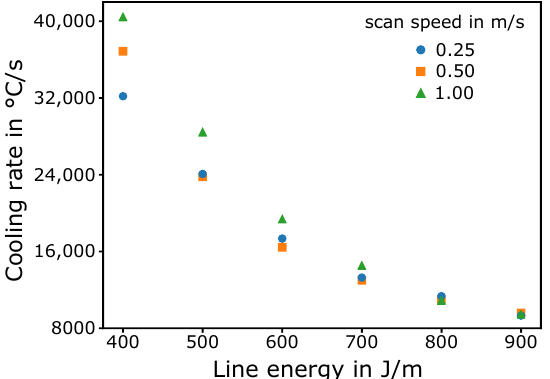
Figure 10. Cooling rate at melt-pool border for several scan speeds and line